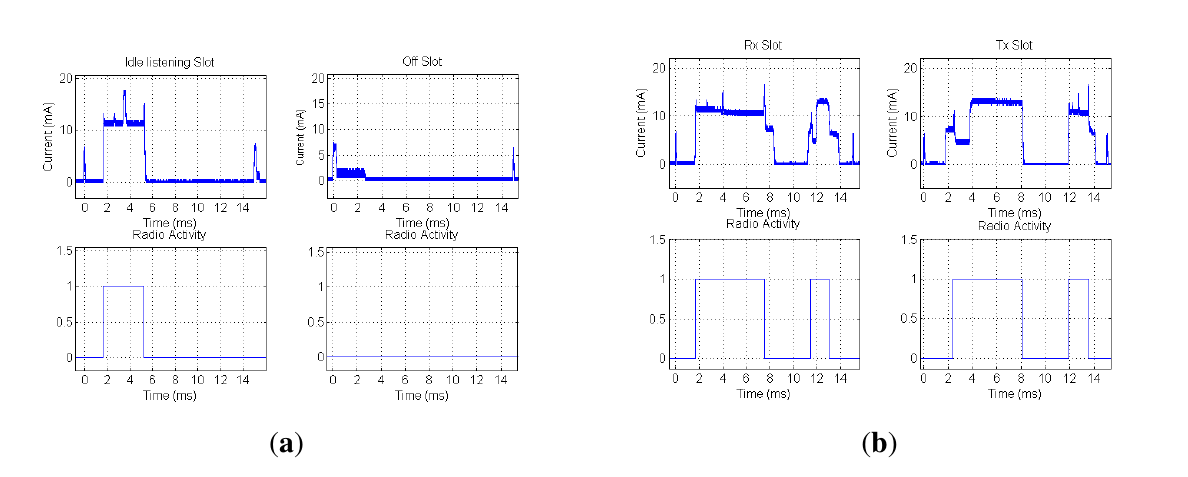
Figure 5. Measured current draw on a TelosB mote. ( a ) Idle listen and off slots; ( b ) transmission and reception